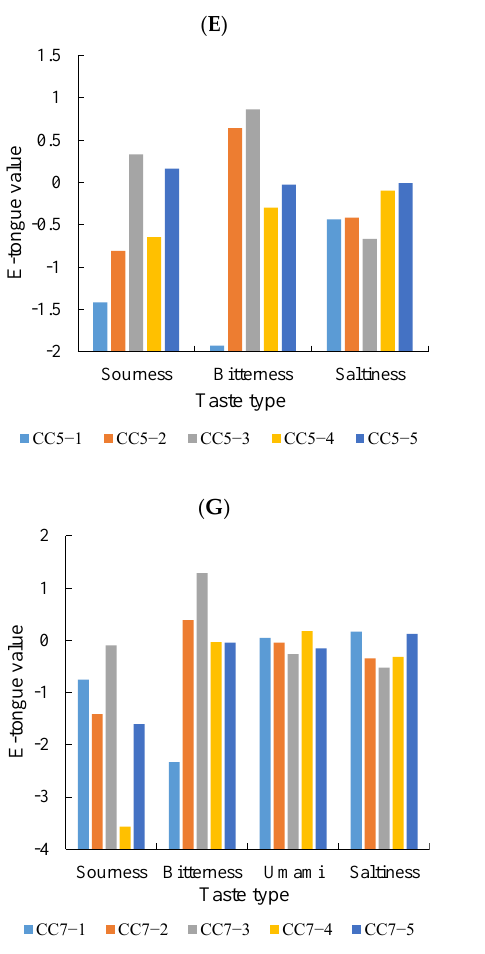
Figure 4. Electronic tongue results of the standard compounds (( A ) electronic tongue results of 5′ -GMP in different con- centration (CC1 - 1: 378.25 μg/mL , CC1-2: 151.30 μg/mL , CC1-3: 75.65 μg/mL , CC1-4: 37.83 μg/mL , CC1-5: 15.13 μg/mL ); ( B ) electronic tongue results of malic acid in different concentration (CC2 - 1: 58.75 μg/mL , CC2-2: 23.50 μg/mL , CC2-3: 11.75 μg/mL , CC2-4: 5.88 μg/mL , CC2-5: 2.35 μg/mL ); ( C ) electronic tongue results of inosine in different concentration